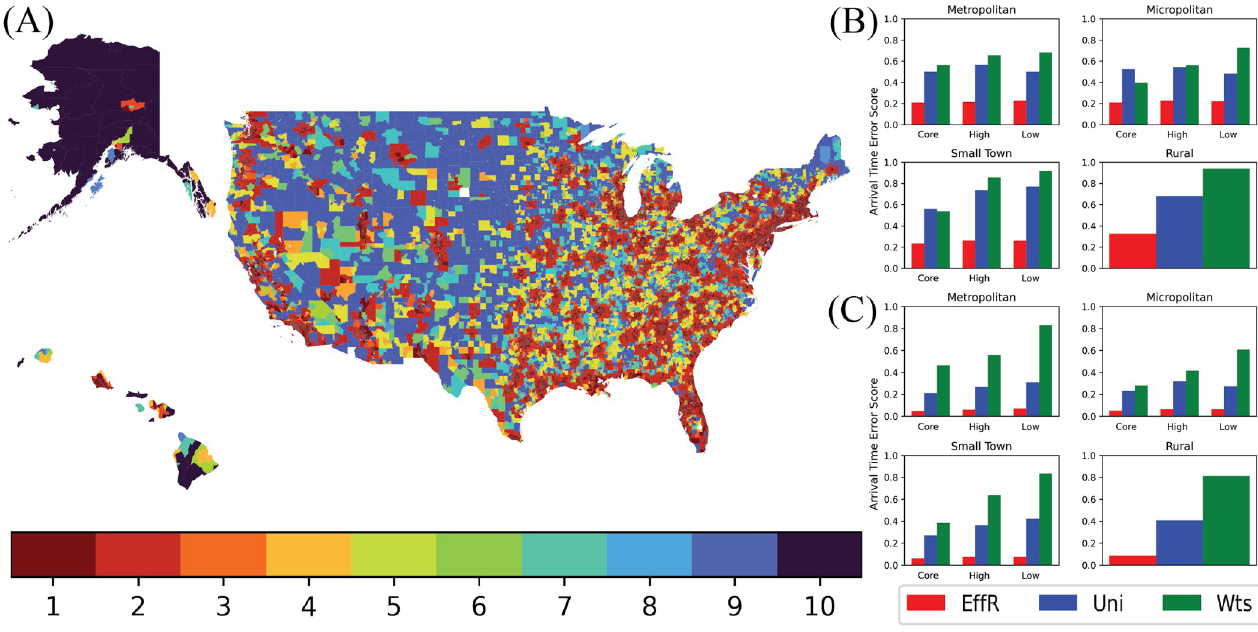
Fig 6. Map of U.S. Census Tracts by RUCA category. (A) map of the U.S. where each census tract is color-coded according to its RUCA designation: 1, 2, 3 are metropolitan core, high, and low commuting, respectively, 4, 5, 6 are micropolitan core, high, and low commuting, respectively, 7, 8, 9 are small town core, high, and low commuting, respectively, and 10 is rural. On the right, we show the arrival time error for sparsifiers that sample s = 0.1 m edges across the 10 RUCA categories for (B) the localized initial condition and (C) the dispersed initial condition. Across all RUCA categories, effective resistance performs better than uniform or weight-based sampling. This effect is especially pronounced for low-commuting areas, which have fewer or lower-weighted edges connecting them to the rest of the network. Base map provided by U.S. Census Bureau (https://www2.census.gov/geo/tiger/TIGER2016/TRACT/) and is covered under public